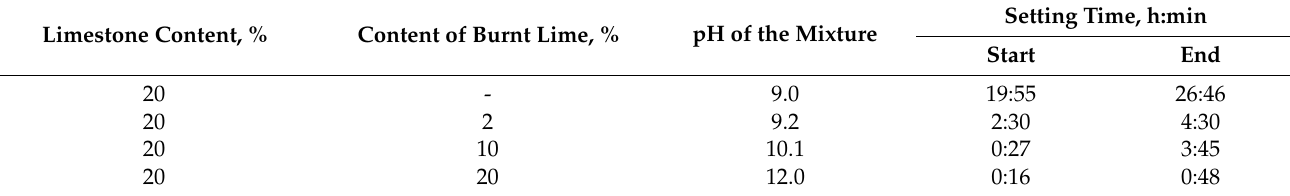
Table 2. Effect of quicklime on setting time.